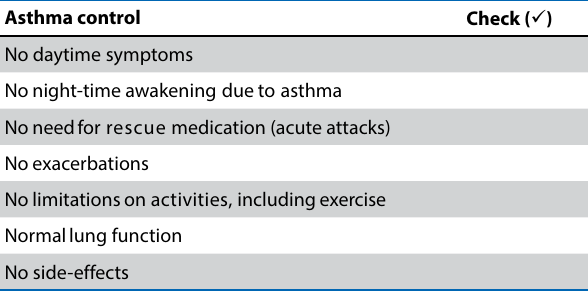
Table III: Parameters that define effective asthma control 14